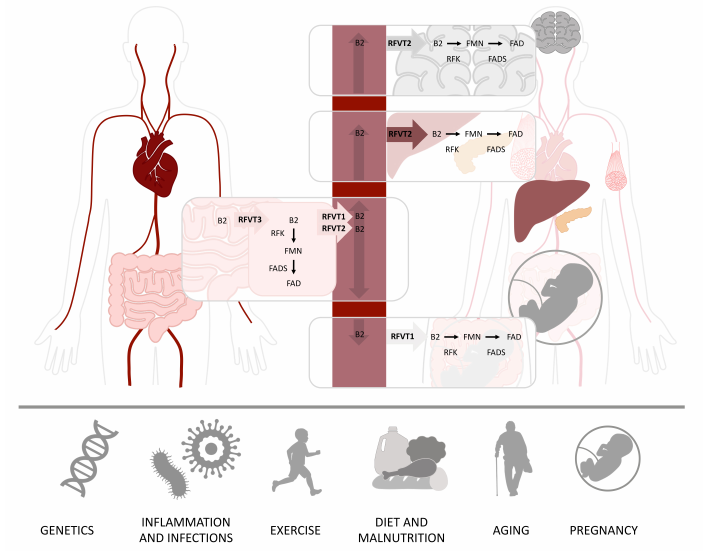
Figure 1. Riboflavin metabolism and its interaction with environmental factors. Riboflavin is absorbed from the gastrointestinal tract predominantly by riboflavin transporter 3 (RFVT3). Inside the gastrointestinal cells, riboflavin can either be further metabolized to flavin mononucleotide (FMN) by riboflavin kinase (RFK) or to flavin adenine dinucleotide (FAD) by FAD synthase (FADS) or transported to the bloodstream by riboflavin transporter 1 (RFVT1) and riboflavin transporter 2 (RFVT2). Riboflavin is distributed via the bloodstream to its destination cells. In addition to being expressed in the gastrointestinal system, RFVT1 is expressed in the placenta, where it carries riboflavin from maternal bloodstream to fetal bloodstream. RFVT2 is expressed all over the body and highly expressed in the brain, endocrine organs, such as pancreas, but also in the liver and muscle tissue. Inside the destination cells, riboflavin is used directly or transformed into either FMN or FAD, which are used as cofactors for several processes. Several factors can affect human riboflavin status, hereunder, genetics, inflammation and infections, exercise, diet and nutrition, aging and